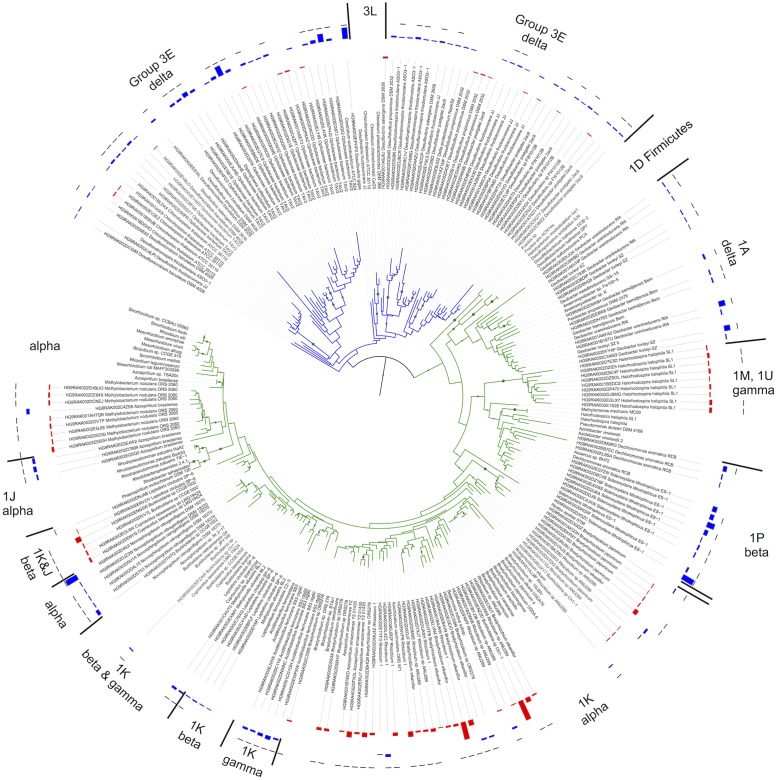
Neighbor joining tree based on 116 comparable NifH amino acid positions using reference sequences obtained from the hand-curated NifH database used for BLASTp assignment. Cluster representative sequences representing those clusters that constituted the SIMPER results were chosen. Bootstrap values >50% are indicated by branch symbols. Group names (e.g., 3E) indicated are based upon the ARB database. The innermost two data fields indicate the relative abundances for each OTU in the above water table (AWT-red) and below water table (BWT-blue). The outermost field indicates significant differences (t-test, p < 0.05) between the BWT and AWT relative abundances (black bar = significant, no bar = not significant).